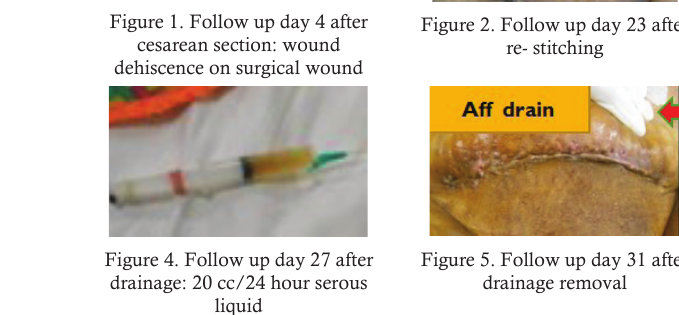
Figure 2. Follow up day 23 after re- stitching